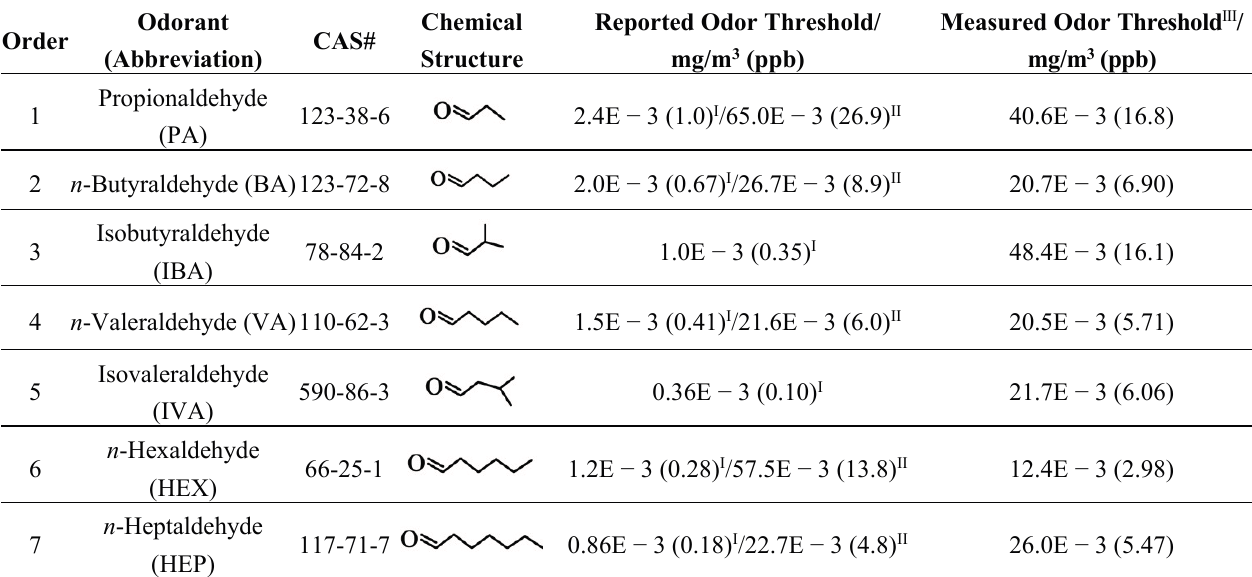
Table 1. List of stimuli investigated for the PDE